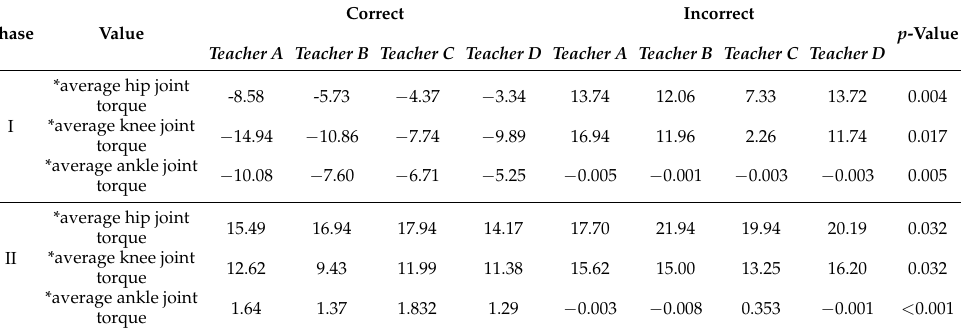
Table 4. Joint torque measured in the robot patient.